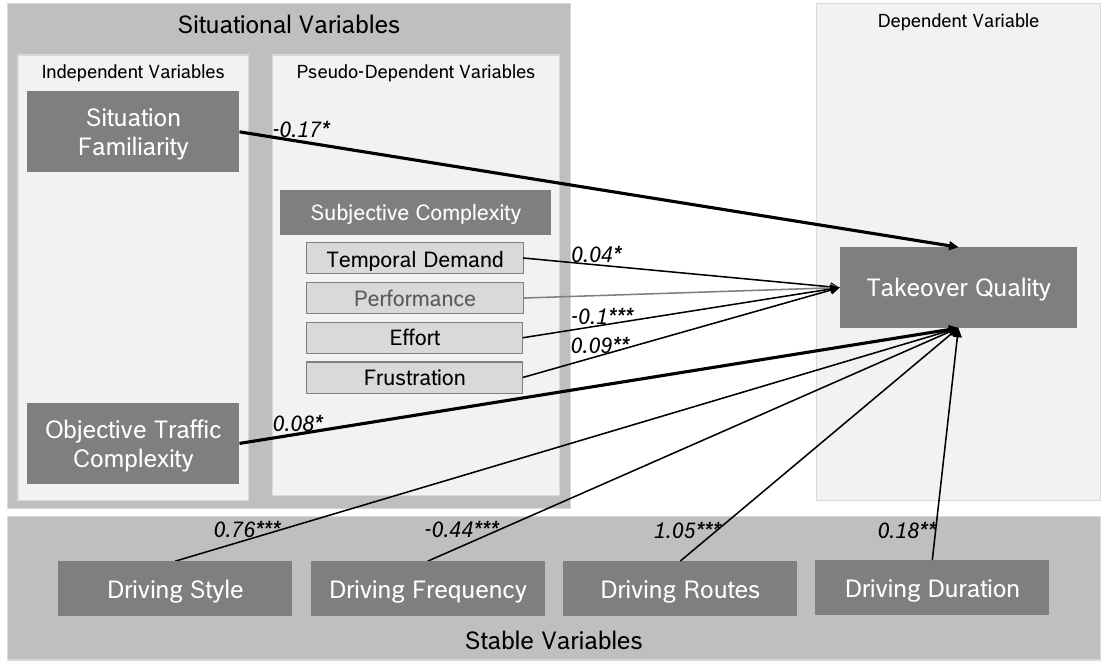
Figure 6. Multiple linear regression results for stable and situational variables on takeover quality. β coefficients indicate the slope of the relationship in the multiple regression (significance codes: 0 ‘***’ 0.001 ‘**’ 0.01 ‘*’